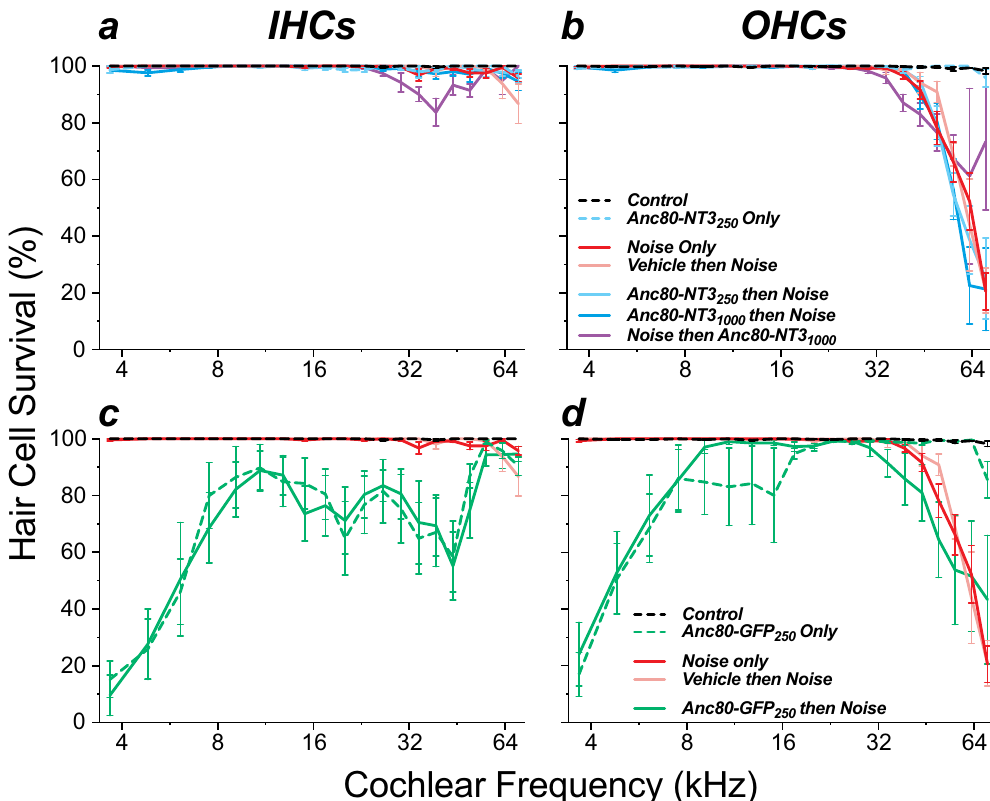
Figure 6. NT3 overexpression did not affect noise-induced hair cell loss ( a,b ), while GFP overexpression caused IHC loss, with or without noise exposure ( c,d ). Means ( ± SEMs) are shown. Group sizes were as follows: Controls (n = 6), Noise Only (n = 7), Vehicle then Noise (n = 4), Anc80-NT3 250 Only (n = 4), Anc80-NT3 250 then Noise (n = 7), Anc80-NT3 1000 then Noise (n = 7), Noise then Anc80-NT3 1000 (n = 5), Anc80-GFP 250 Only (n = 5), and Anc80-GFP 250 then Noise (n = 5). Survival values are absolute, i.e. not